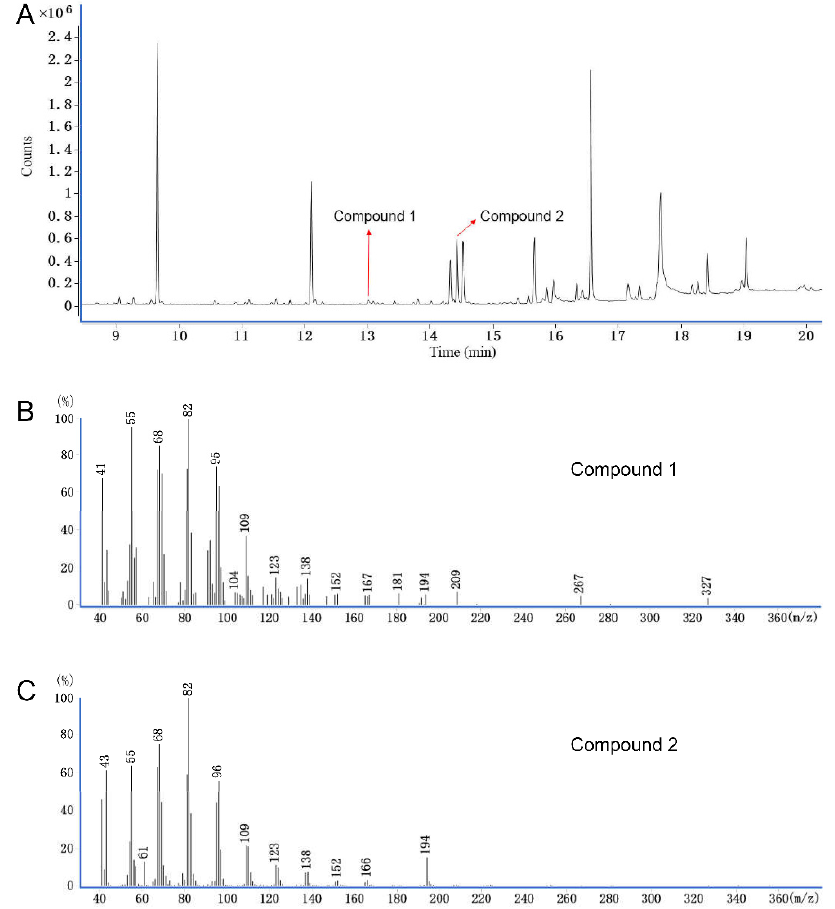
Figure 3. Gas chromatography–mass spectrometry (GC–MS) analysis of pooled Archips strojny female moth crude pheromone gland extract (n = 8). ( A ) Total ion chromatogram (TIC), ( B ) mass spectrum of Compound 1 ((Z)-11-tetradecenyl alcohol (Z11-14:OH), retention time (RT) 13.01 min), ( C ) mass spectrum of Compound 2 ((Z)-11-tetradecenyl acetate (Z11-14:Ac), RT 14.43 min).